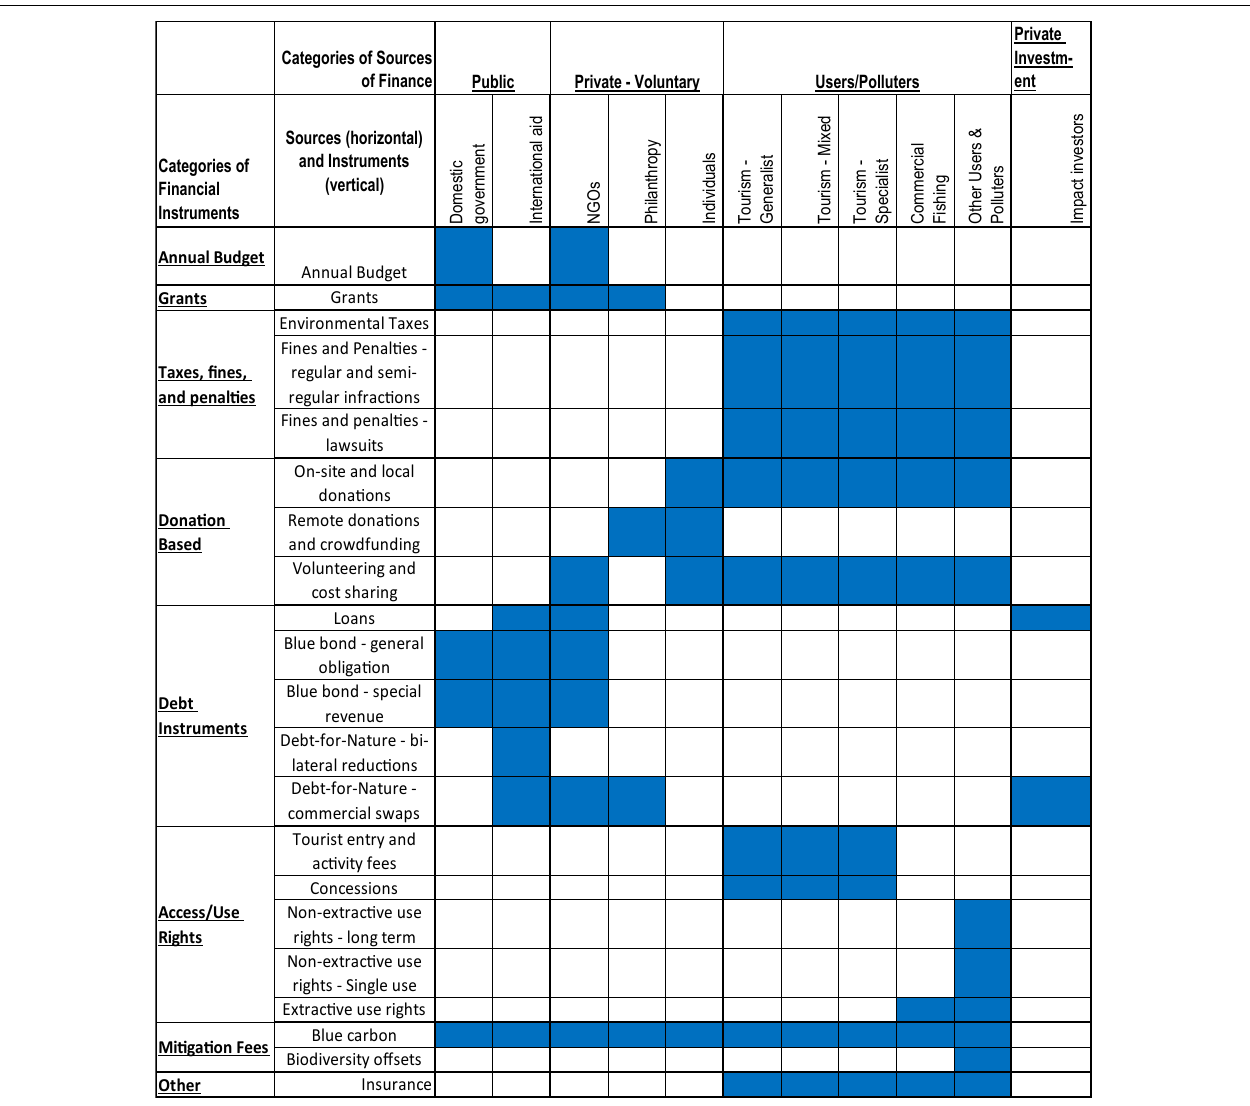
and/or instruments functioning together, which may become more common with the rising popularity of blended finance mechanisms (Silver and Campbell, 2018; Virdin et al., 2018). The 11 or more sources and 21 instruments were also organized to consolidate different types of mechanisms for sake of practicality for the evaluation tool, but within them there can be many more types of sources and instruments [e.g., there are several of environmental taxes and similar economic instruments (Meyers et al.,